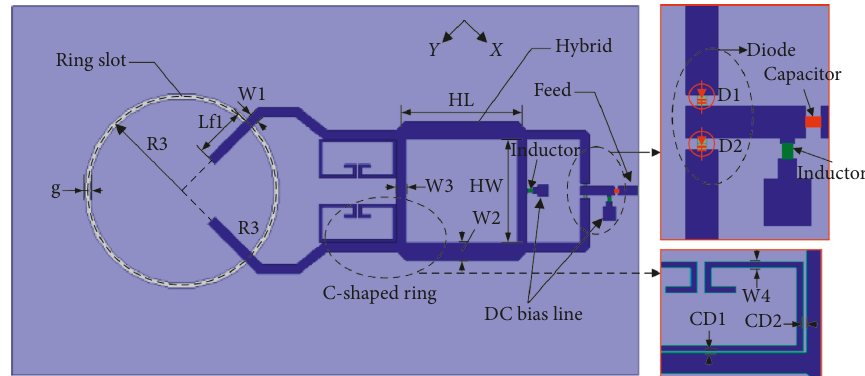
Figure 4: Reconfigurable orthogonal feeding network for CP antenna.